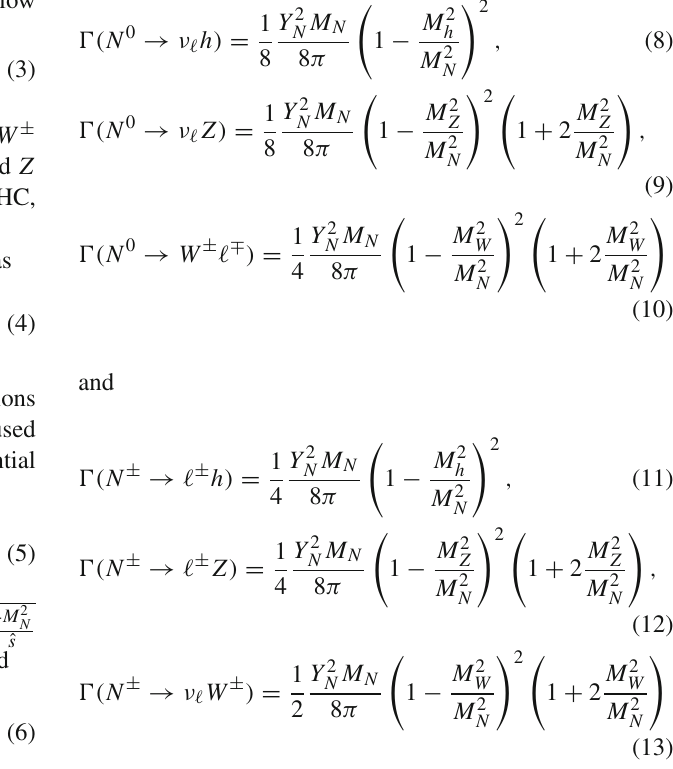
˜ φ = i σ 2 φ ∗ and the N i are ) for each generation i i